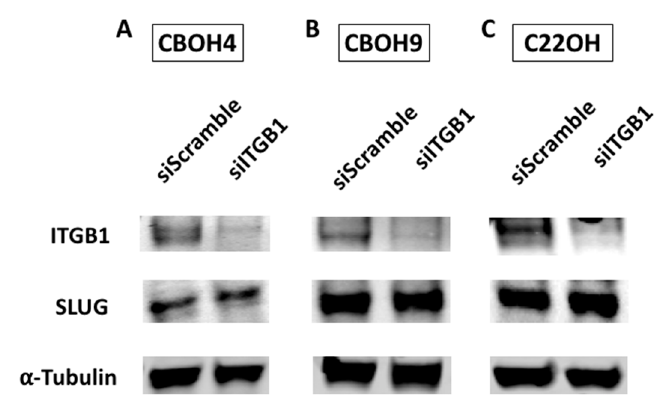
Figure 2. Knockdown of ITGB1 does not a ff ect SLUG expression in CTCs. Western blot analysis of SLUG protein expression levels when ITGB1 is transiently knocked down in ( A ) CBOH4, ( B ) CBOH9, and ( C ) C22OH. Expression was normalized against alpha-tubulin. Experiments were carried out at least 3 times.